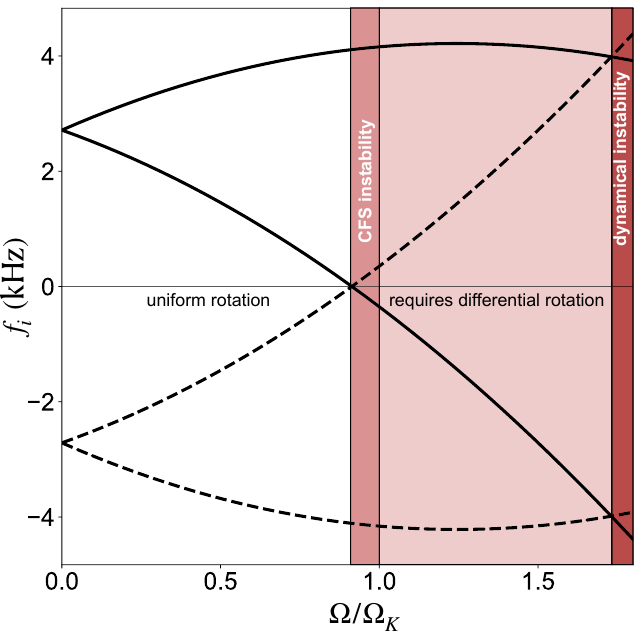
Figure 2. Illustrating the numerical results from [105] for the l = 2 f-modes of rotating neutron stars. The inertial frame mode frequency f i = ω i /2 π (in kHz) is shown as function of the (uniform) rotation frequency Ω (scaled to the Kepler frequency Ω K